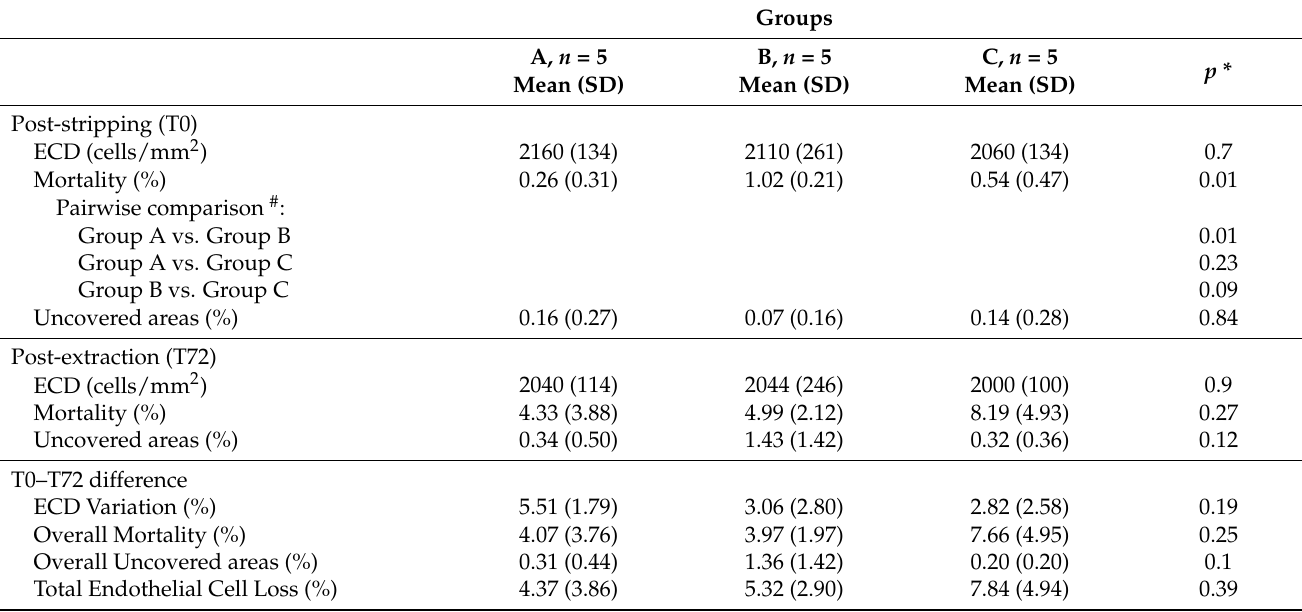
Table 2. Average values and differences in Endothelial Cell Density, Mortality and Uncovered Areas at T0 and